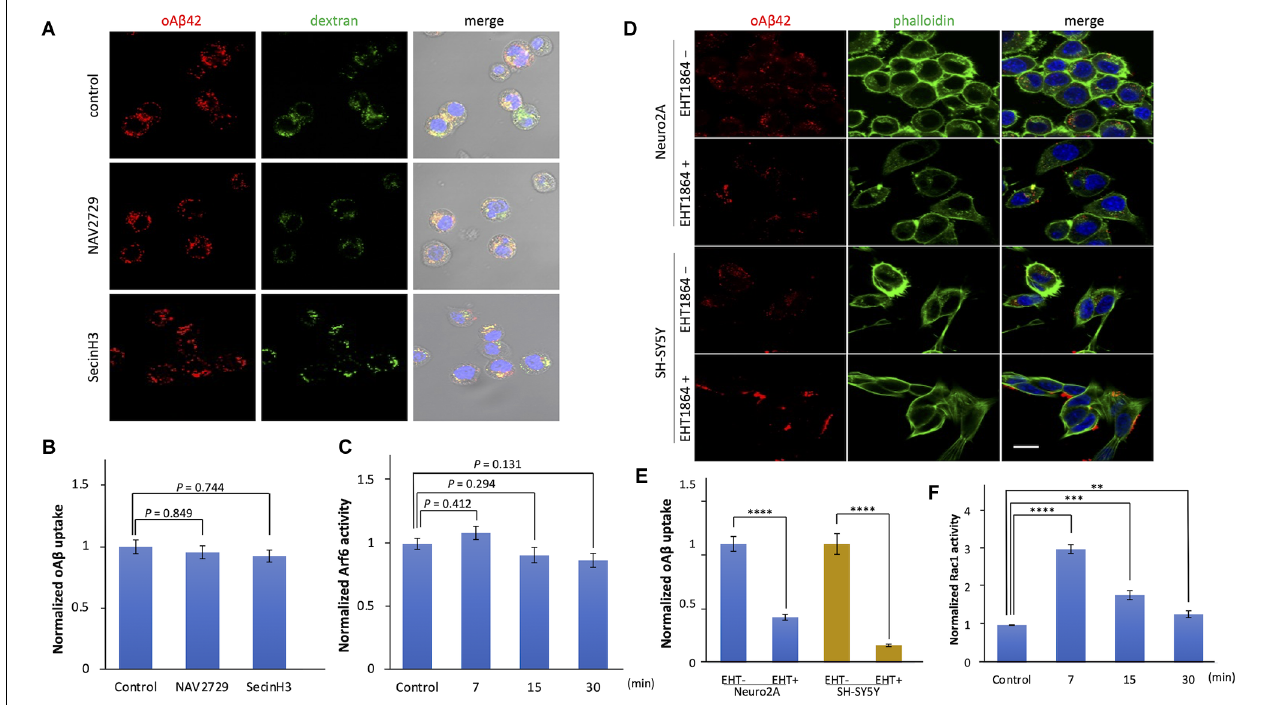
FIGURE 5 | The effects of Arf6 and Rac1 inhibitors on the uptake of oligomeric amyloid beta. (A) Cells were treated with NAV 2729 and SecinH3 for 1 h, followed by incubation with 5 µ M TMR-oA β 42 (red) and 2.5 mg/ml FITC-dextran (green) for 90 min at 37 ◦ C. Nuclei were visualized with DAPI (blue). Scale bar = 10 µ m. (B) Quantification of the uptake of oA β 42 by confocal microscopy in the presence of the Arf6 inhibitors, and data are presented as mean fluorescence normalized to control ( n = 3). Significance was established by ANOVA followed by the Dunnett–Square test. (C) The change in Arf6 activity in Neuro2A cells by the treatment of oA β 42 was measured using G-LISA. Normalized data are presented as mean ± SEM. Significance was established by ANOVA followed by the Dunnett–Square test. (D) Actin and nuclei were visualized with Alexa Fluor 488 phalloidin conjugates (green) and DAPI, respectively. Scale bar = 10 µ m. (E) Quantification of the uptake of oA β 42 by confocal microscopy in the presence of EHT1864. Data are presented as mean fluorescence normalized to without EHT ( n = 3). Significance was established by Student’s t-test. (F) The change in Rac-1 activity in Neuro2A cells upon oA β 42 treatment was measured using G-LISA. Normalized data are presented as mean ± SEM. Significance was established by ANOVA followed by the Dunnett–Square test. ∗∗ p < 0.01; ∗∗∗ p < 0.001; ∗∗∗∗ p <